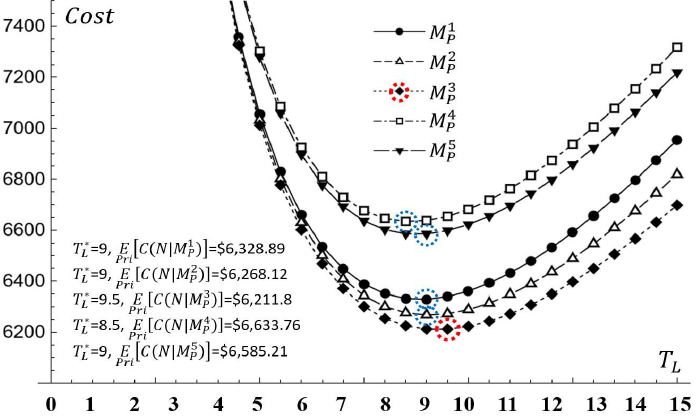
Figure 6. The overall costs per unit and year for all PM alternatives estimated by the prior analysis. Table 3. The expected preventive cost, repair cost, penalty cost, replacement cost and overall cost per unit and year for PM Alternatives 2, 3, 4 estimated by the prior analysis.